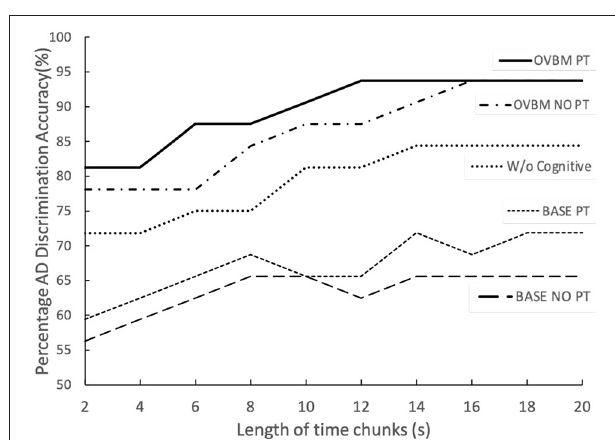
FIGURE 5 | The two top lines illustrate the full OVBM performance, with its biomarker feature models, as a function of chunk size. PT refers to individually fine-tuning each biomarker model for AD before re-training the whole OVBM. The middle line shows the OVBM without the cognitive core, illustrating how it boosts performance by about 10% across the board. Baseline PT is the OVBM architecture with each ResNet50 inside individually trained on AD before retraining them together in the OVBM